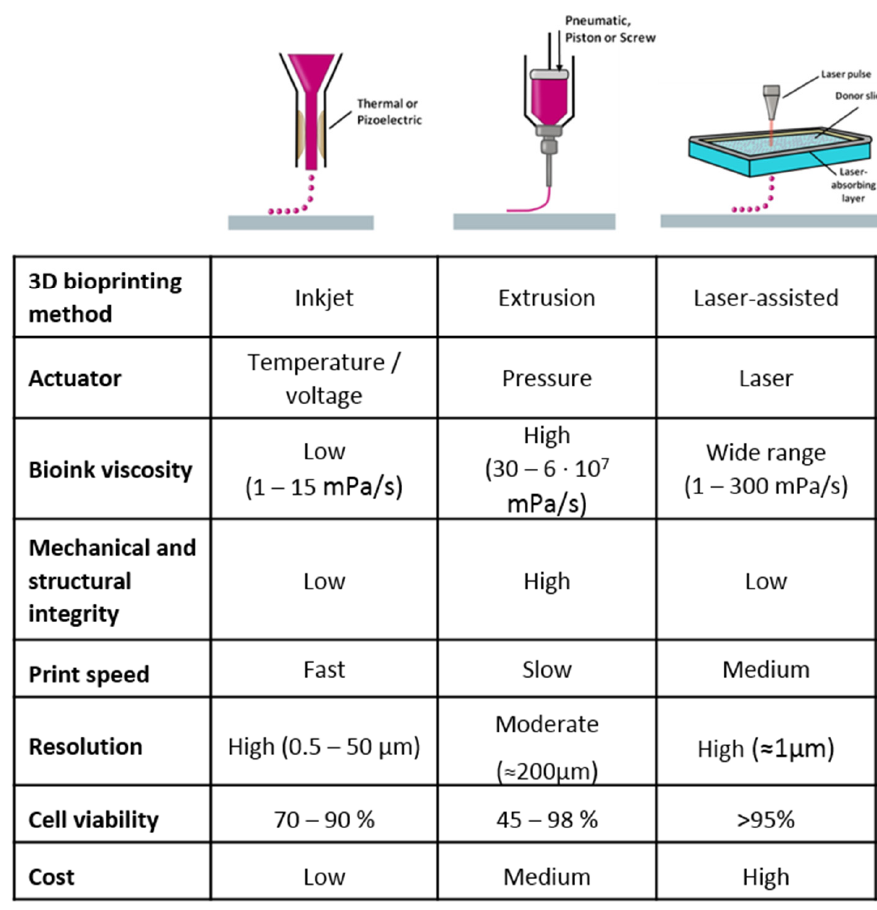
Figure 2. Major three-dimensional bioprinting techniques and their specific features.